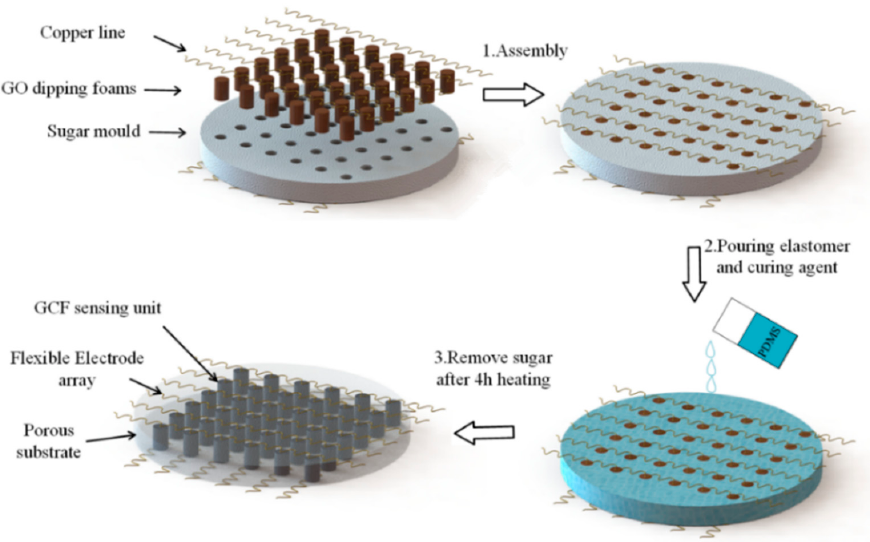
Figure 1. The manufacturing process of the porous substrate and the schematic diagram of the pressure-sensitive array.